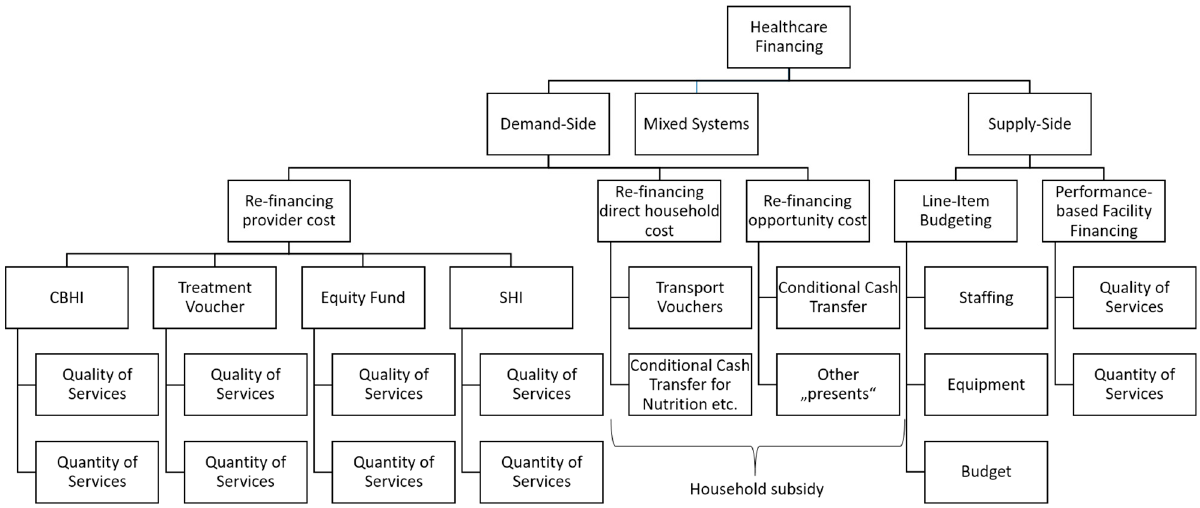
Figure 7. Instruments of healthcare financing. Source: own.